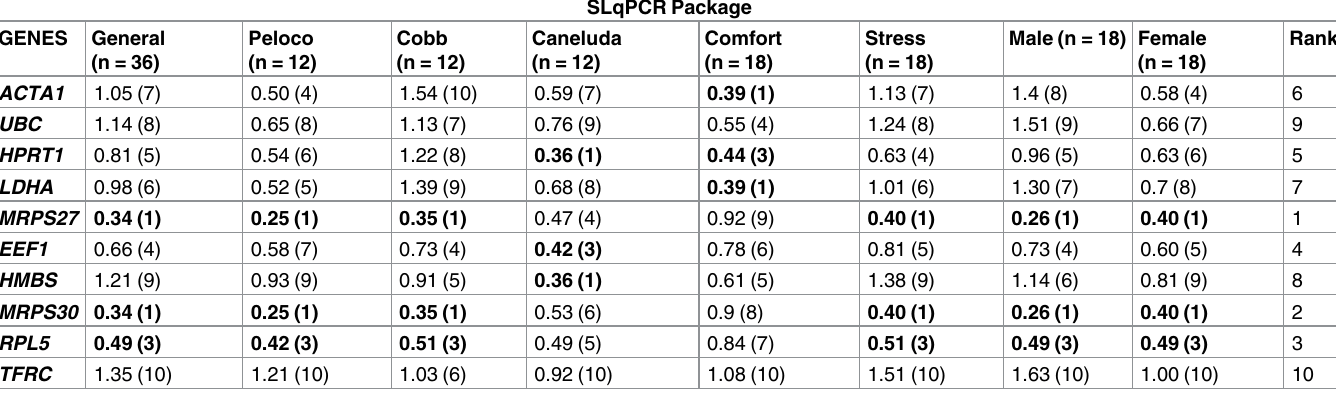
Table 5. Ranking with stability values for each treatment (genetic group, sex, and environment) in chicken obtained from SLqPCR package. Val- ues into the parenthesisrefer to ranking by SLqPCR to each treatment. Values on the last column refer to the ranking positionby RankAggreg package amongall the